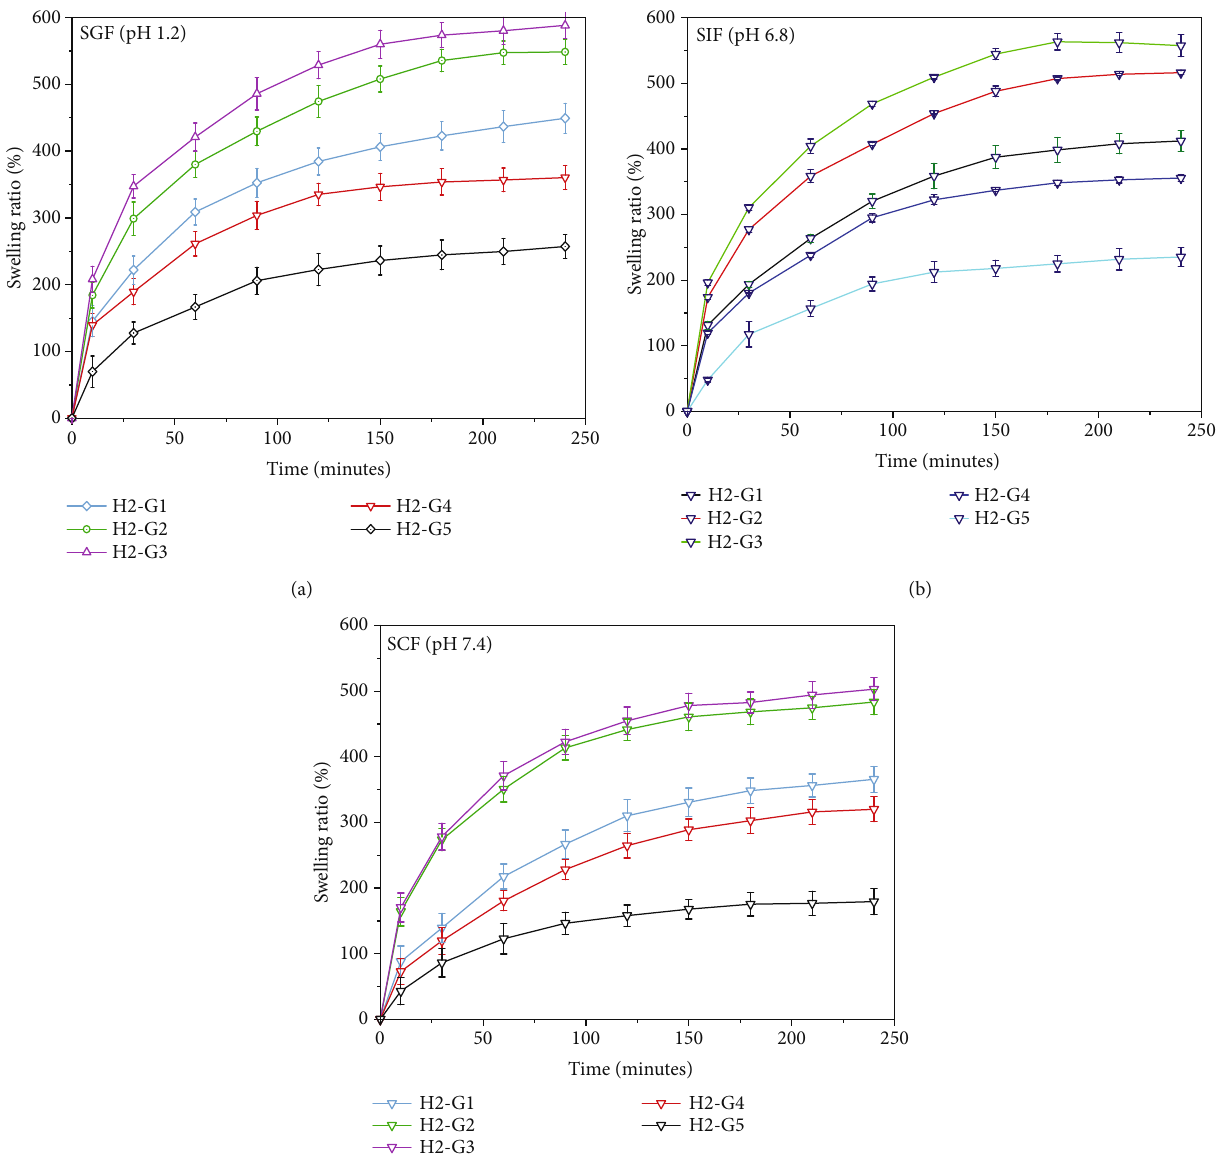
Figure 2: Swelling ratio of hydrogel H2 with increasing glutaraldehyde content in (a) SGF, (b) SIF, and (c)